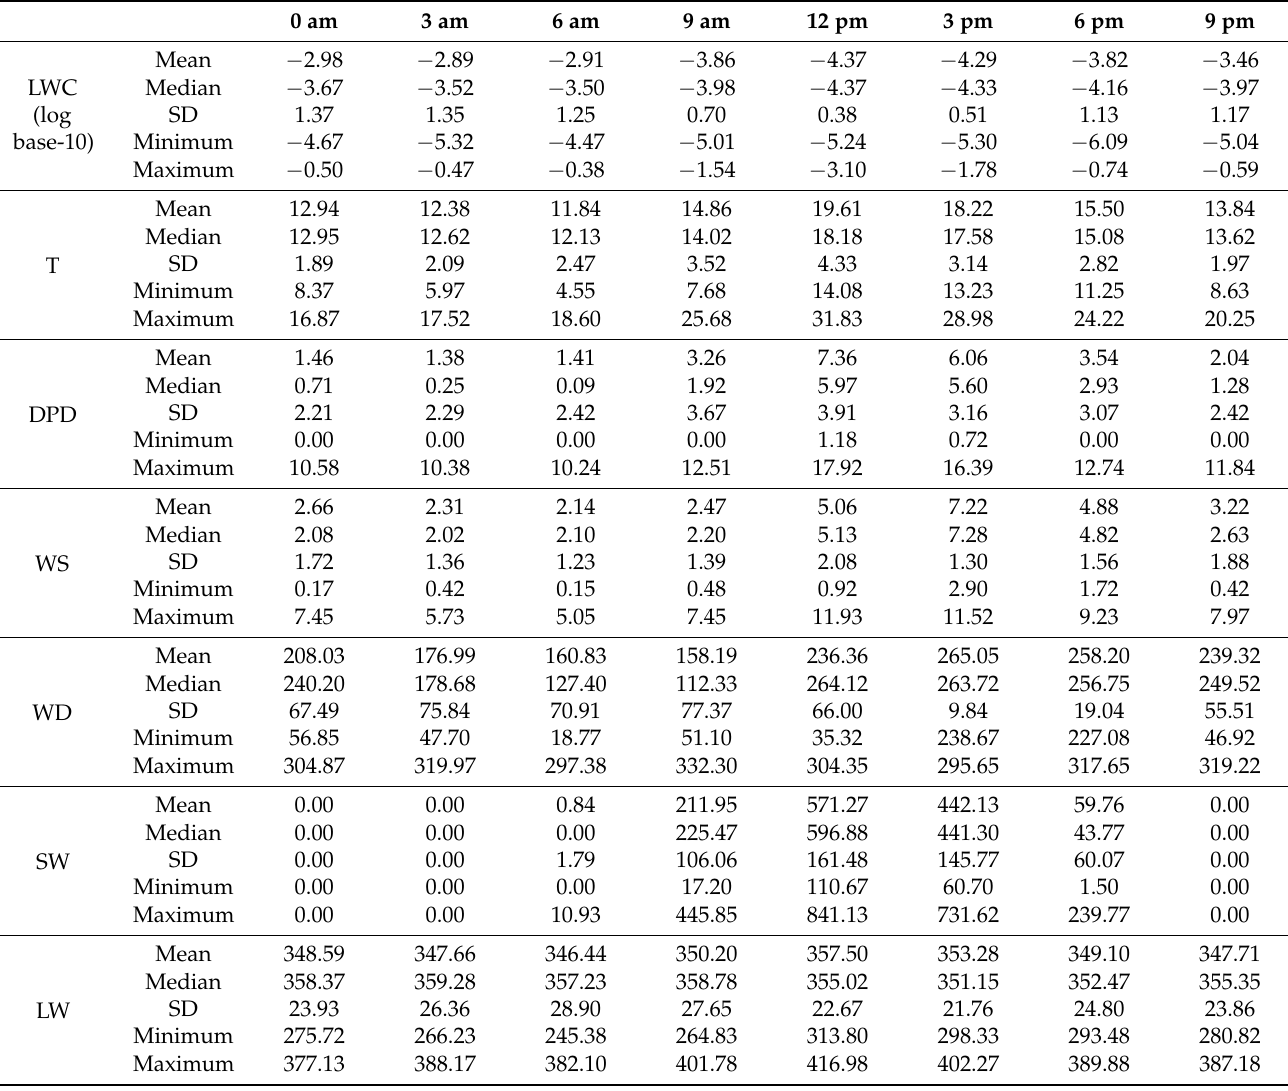
Table 1. Descriptive statistics of liquid water content (LWC), temperature (T), dew point